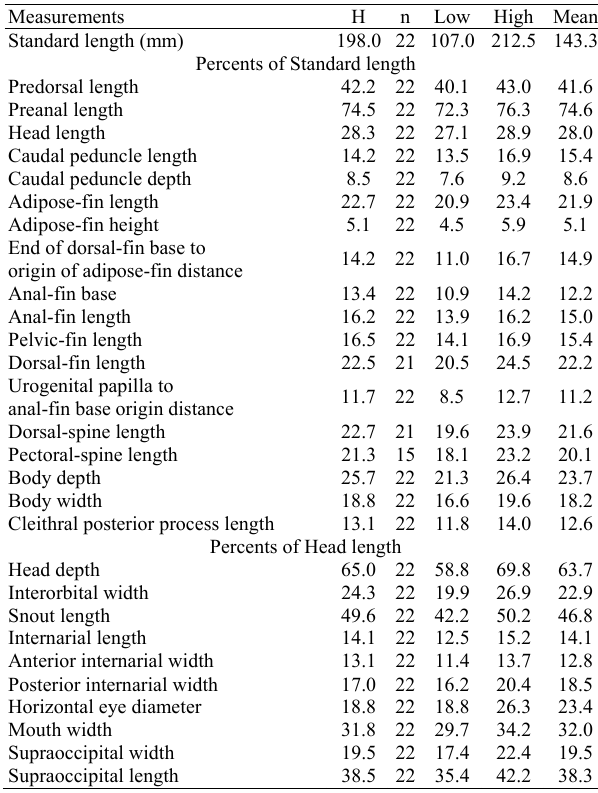
Table 1. Morphometric data of Pimelodus multicratifer . Range includes the holotype